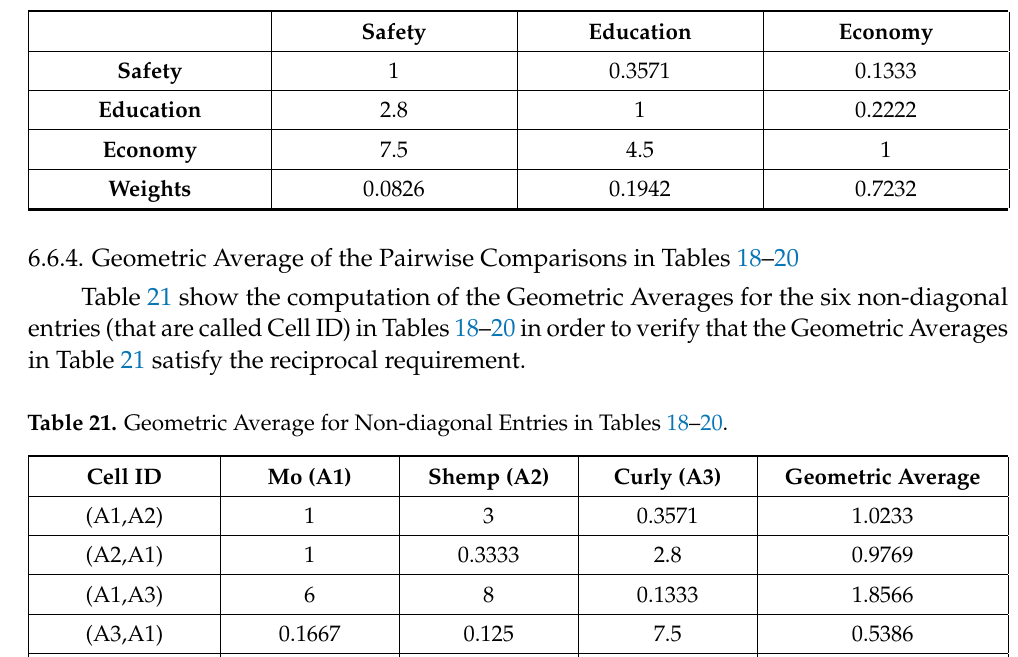
Table 20. Pairwise Comparison Matrix for Curly.